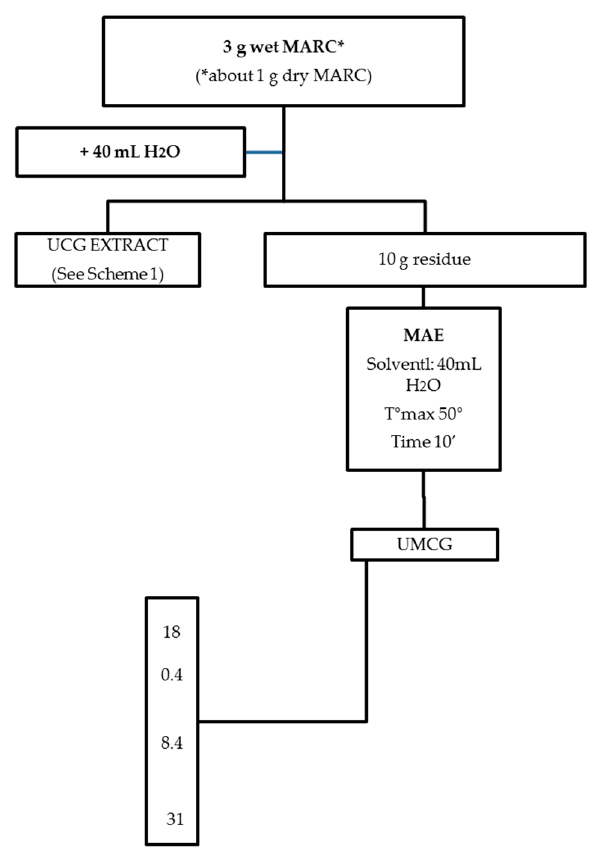
Table 1. Folin–Ciocalteu results of parallel extractions. MWCG UCG UBWCG BOWCG Total polyphenols (TPC) mg GAE/100mL(Mean) Standard error of the mean (SEM) Confidence level (95.0%) Table 2. 2,2-Diphenyl-1-pycrylhydrazyl (DPPH) test results of parallel extractions. MWCG UCG UBWCG BOWCG RSA% of theextracts diluted 1:10 (Mean) Standard error of the mean